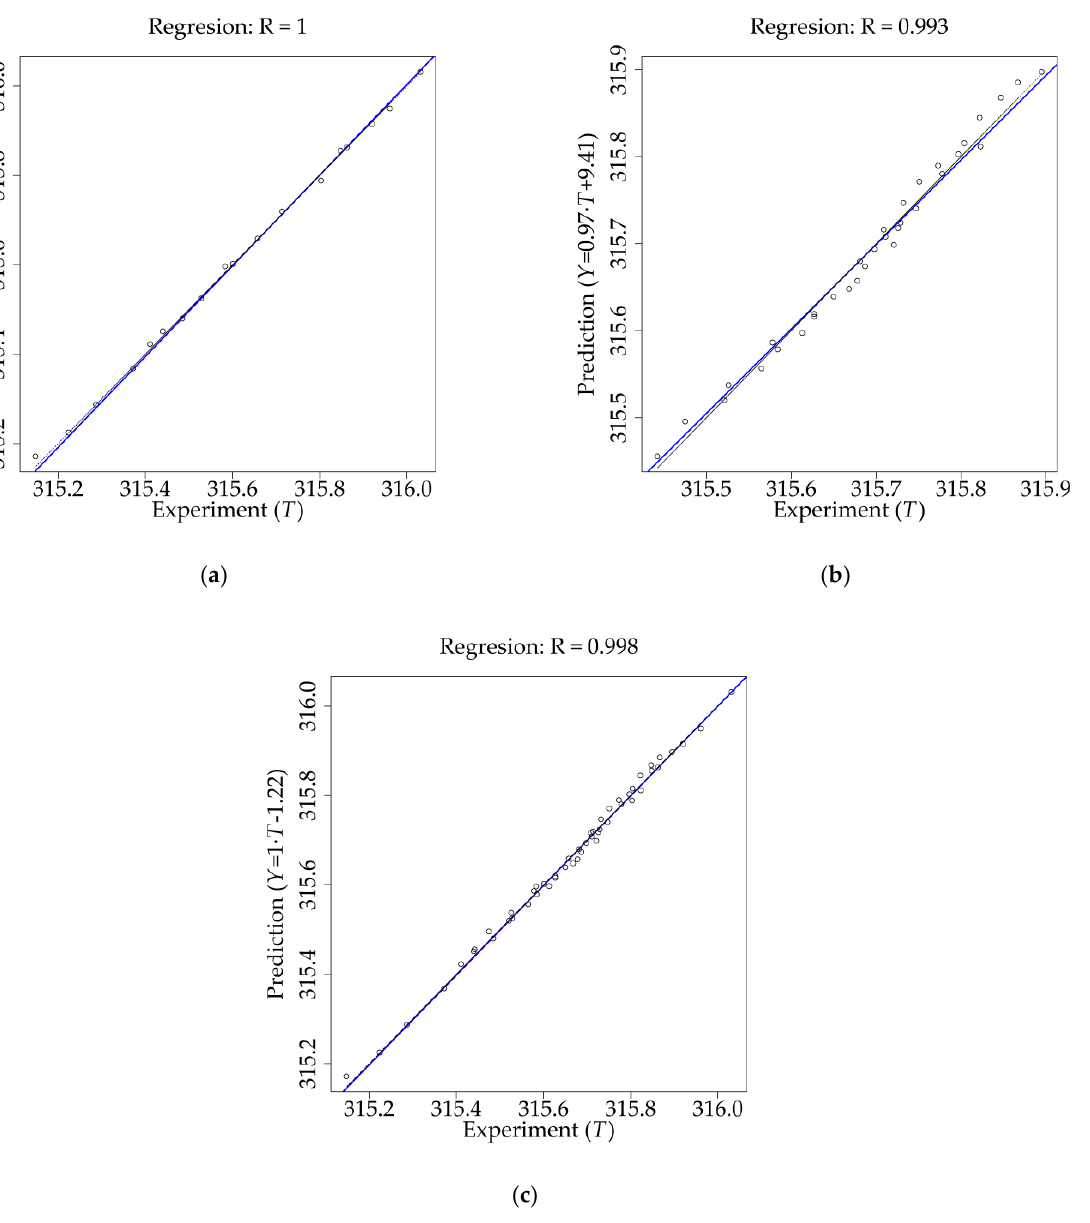
Figure 11. Regression plots for an artificial neural network with Bayesian regularisation back-propagation algorithm (BRANN): ( a ) training data; ( b ) testing data; ( c ) all data.